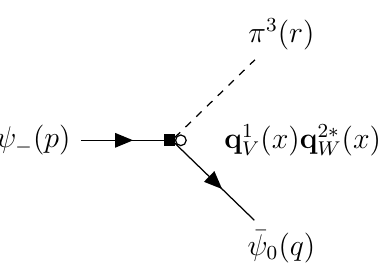
◦ is the vertex proportional